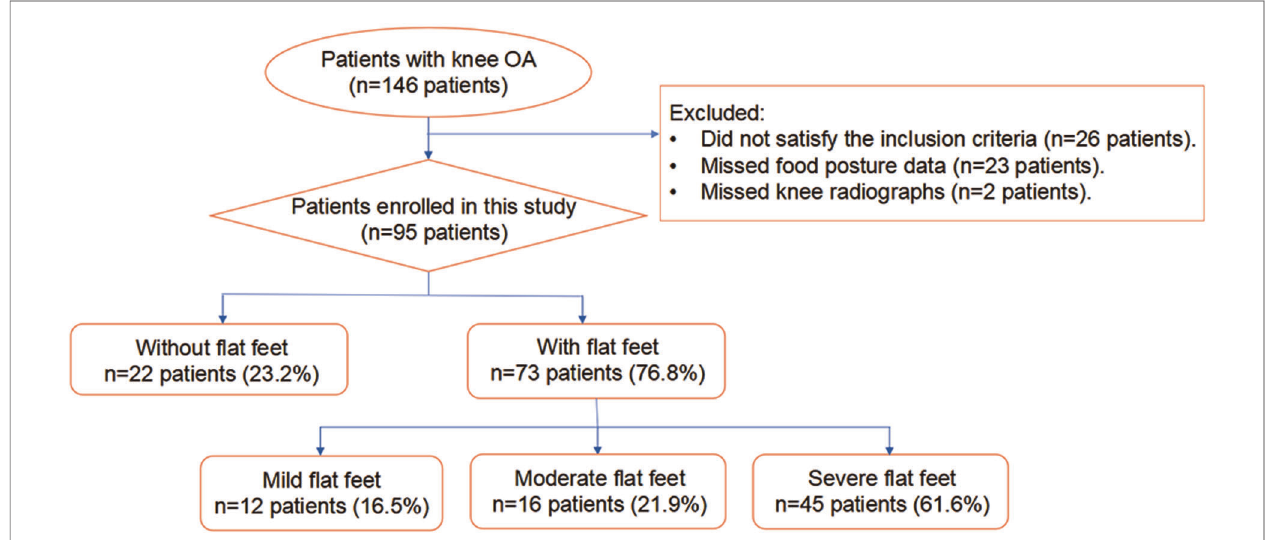
FIGURE 3 | Flow chart showing the distribution of study